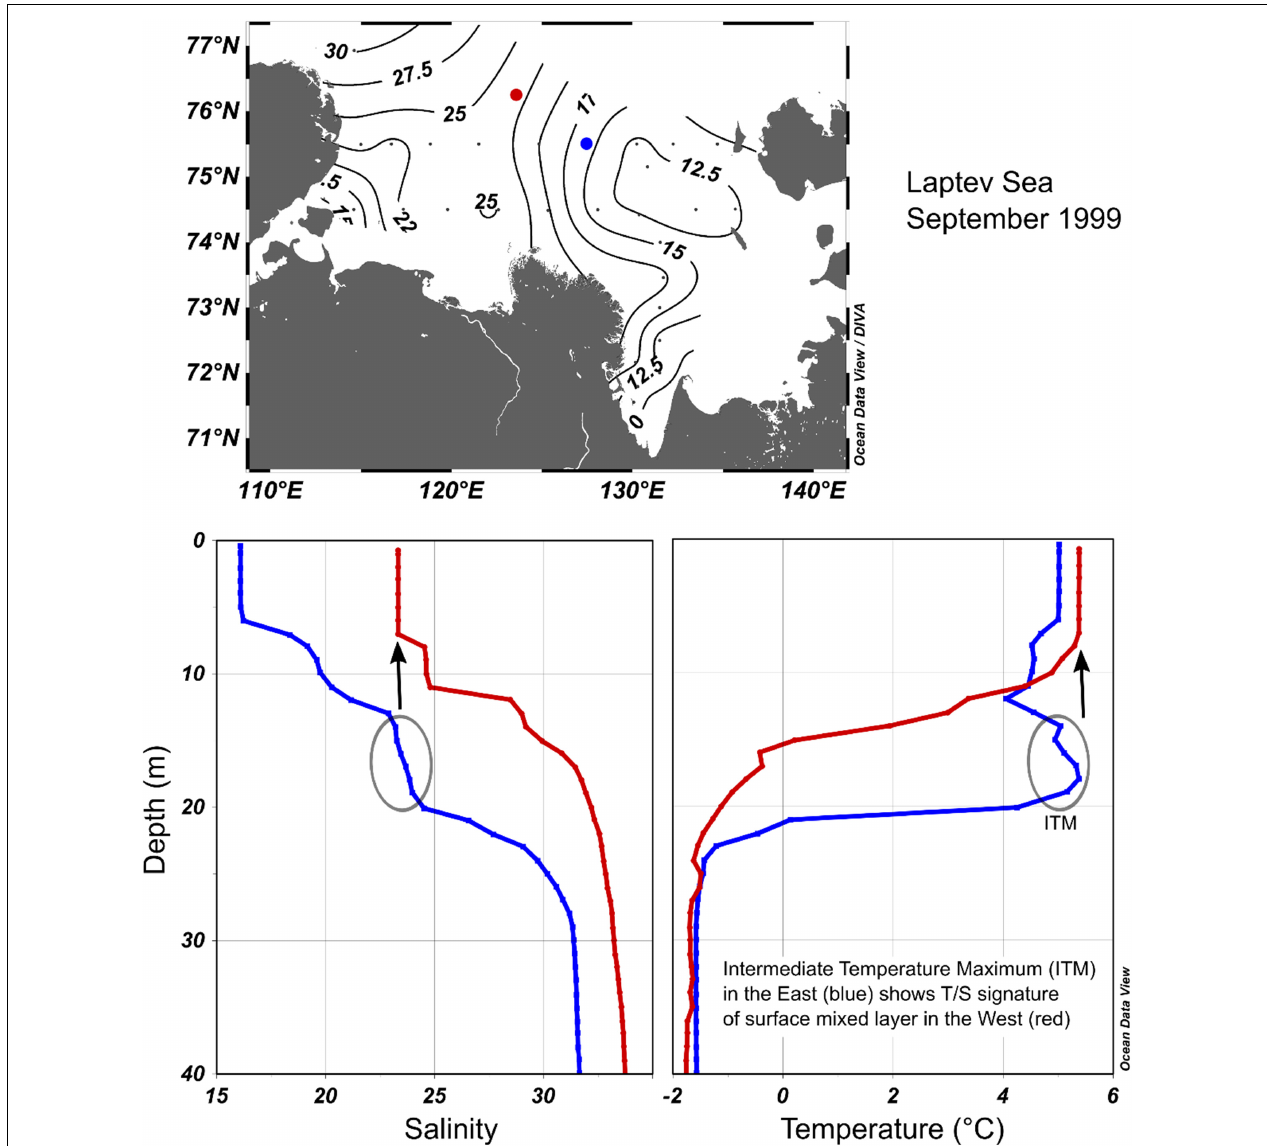
FIGURE 14 | Same as Figure 13 but from a survey in September 1999.